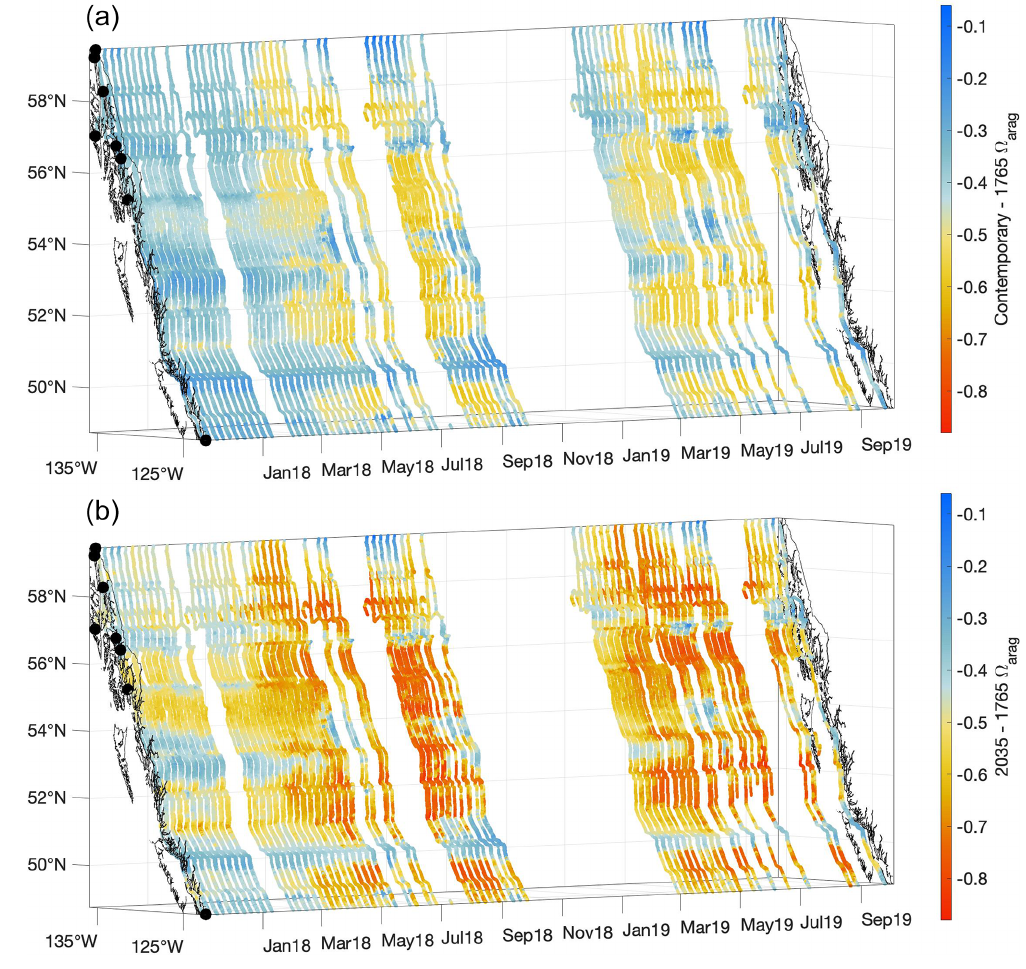
Figure 10. The contemporary (cid:127) arag values minus the estimated values for 1765 (a) and the estimated values for 2035 minus the 1765 values (b) . The x and y axes represent longitude and latitude, respectively, and with the coastline and terminal positions shown as in Fig. 1 and time increasing along the z